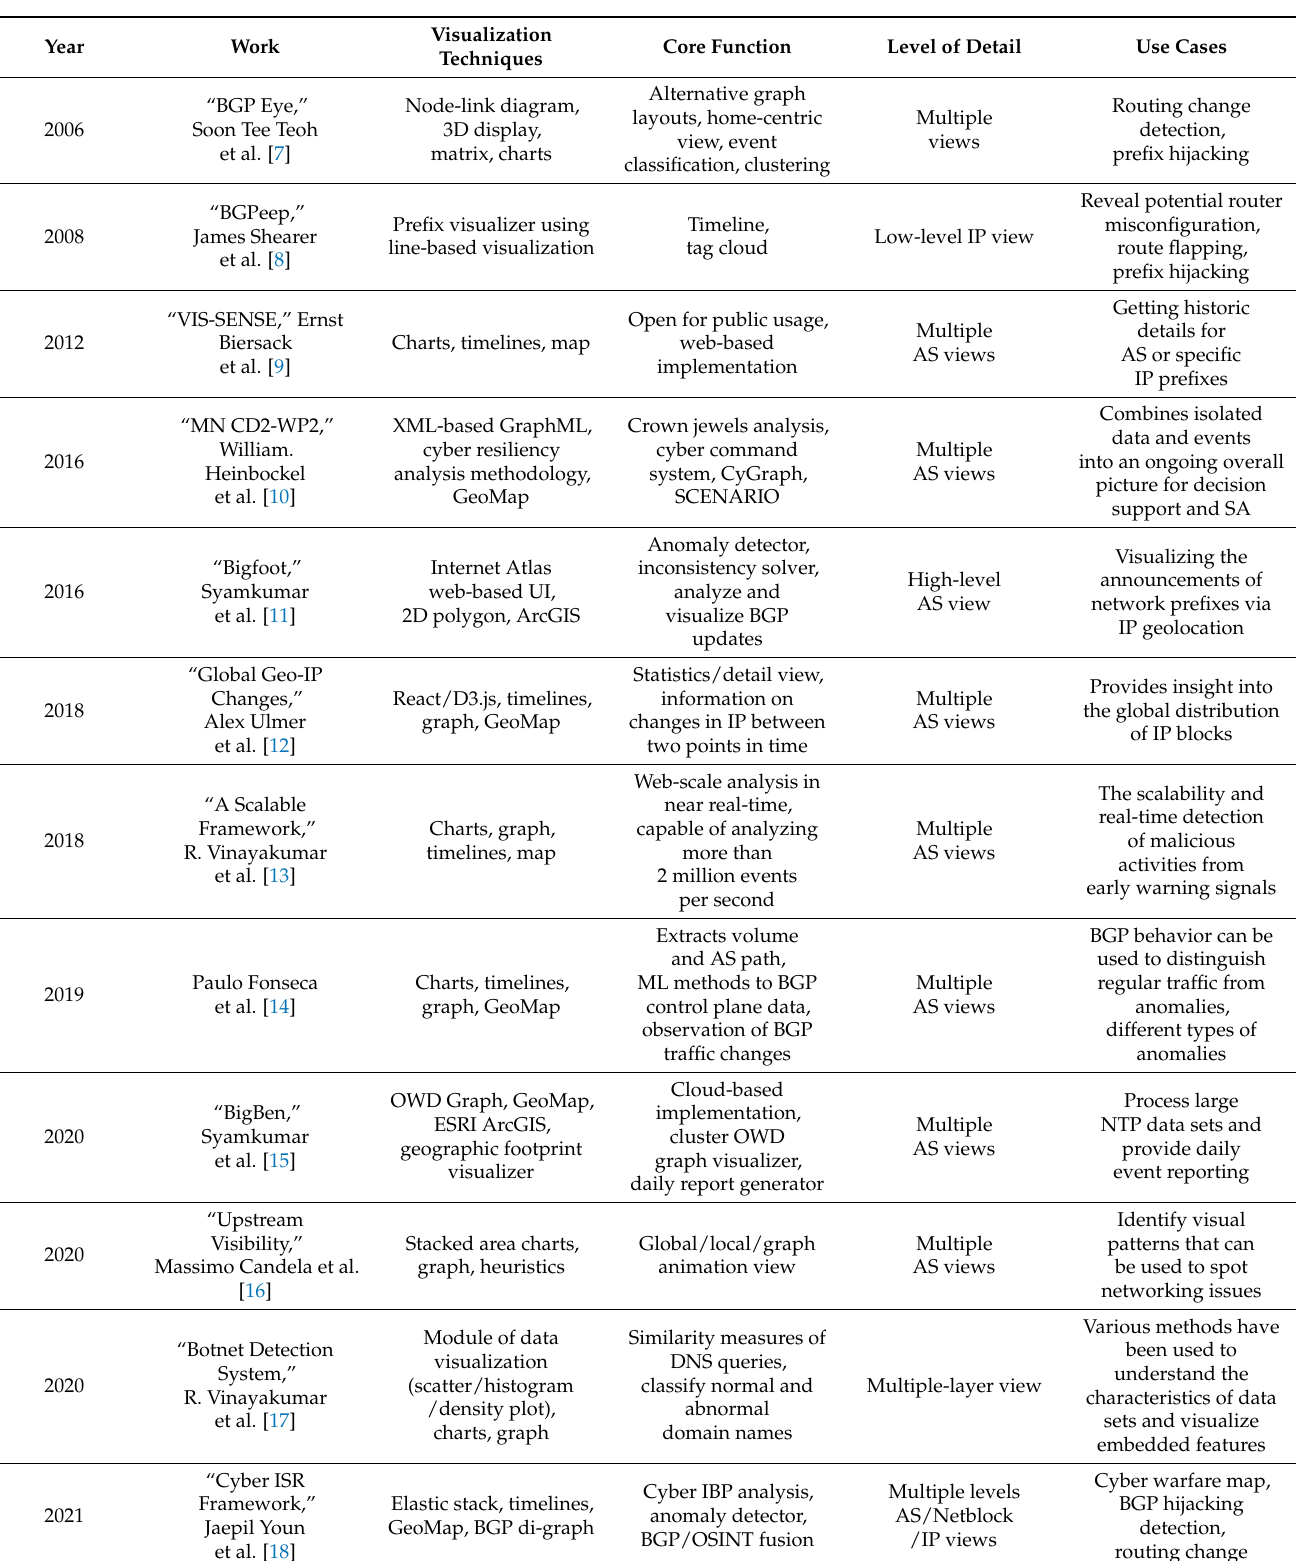
Table 1. Visualization work related to cyber ISR for cyber